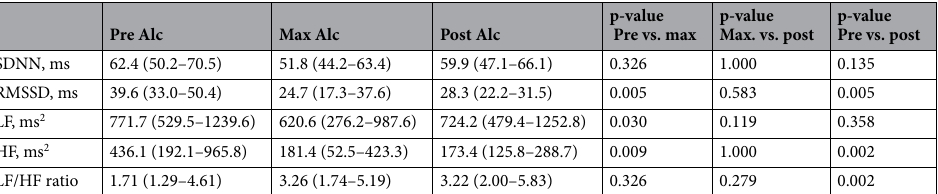
p-value Max. vs. post